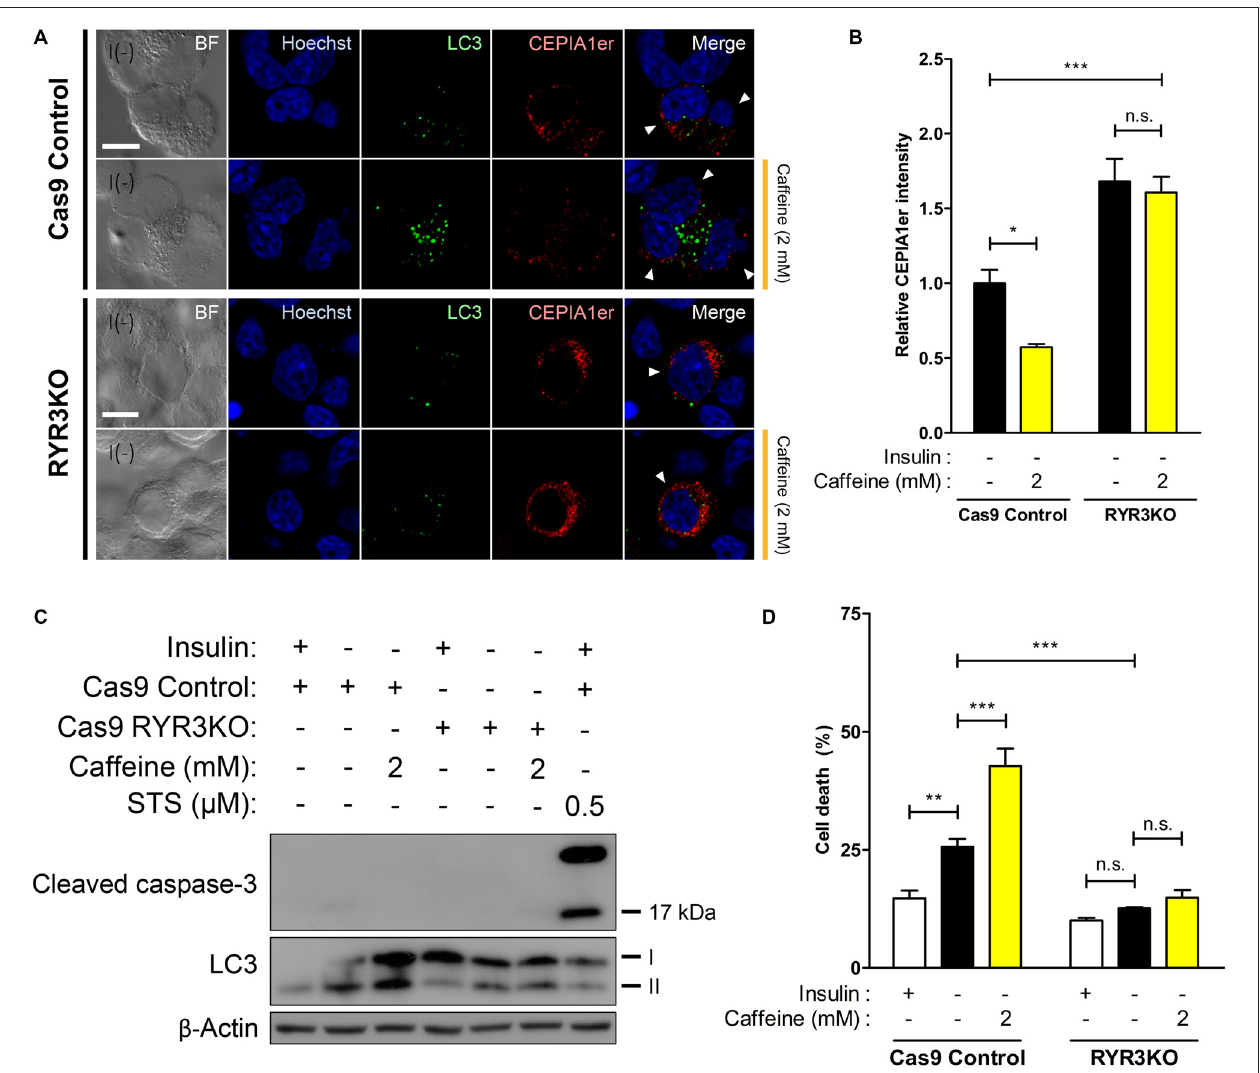
FIGURE 7 | ER Ca 2 + efflux is significantly inhibited in I( − ) RYR3KO HCN cells. (A,B) Caffeine was used to provoke ER-to-cytosol transfer of Ca 2 + in control I( − ) and RYR3KO I( − ) HCN cells. (A) Immunofluorescence images of pCMV R-CEPIA1er in HCN cells experiencing autophagy depicted by puncta formation of EGFP-LC3 24 h following insulin withdrawal. Cells subjected to analysis are indicated by arrowheads. Scale bar, 10 µ m. Fluorescence intensity of CEPIA1er (B) selectively in EGFP-LC3-positive HCN cells was quantified ( n = 36 for Cas9 Control I( − ), 41 for Cas9 Control I( − )/Caffeine, 32 for RYR3KO I( − ), 43 for RYR3KO/Caffeine). The bars represent the mean ± SEM; ∗ p < 0.05, ∗∗∗ p < 0.001; n.s., non-significant. (C,D) Caffeine failed to facilitate ACD of I( − ) HCN cells in the absence of RyR3. (C) Western blot analysis of cleaved caspase-3 and LC3 in I( − ) RYR3KO HCN cells treated with caffeine. (D) Cell death analysis in RYR3KO HCN cells treated with caffeine for 24 h. Each experiment set was performed in triplicate per experiment ( n = 6). The bars represent the mean ± SEM; ∗∗ p < 0.01, ∗∗∗ p < 0.001; n.s.,